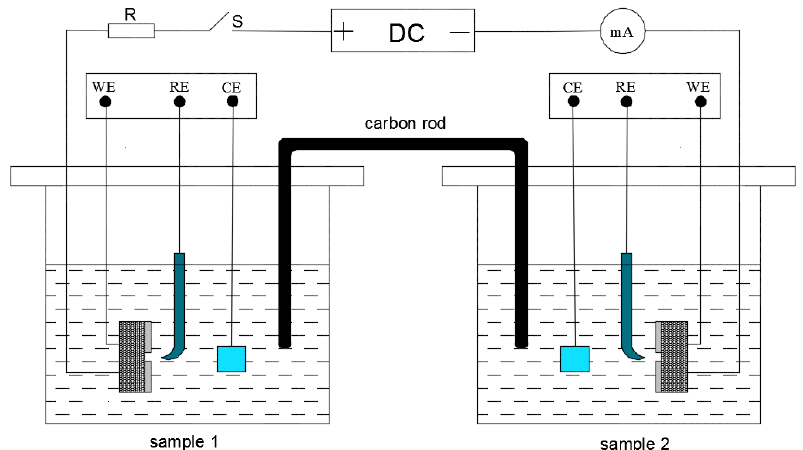
Figure 2. A schematic of the stray direct current (DC) loading and electrochemical testing device. WE, working electrode; RE, reference electrode; CE, counter electrode.